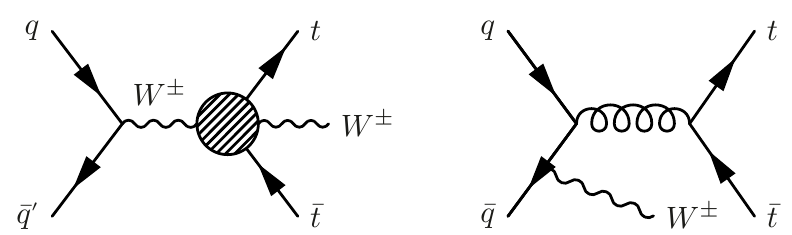
Figure 18. Left : schematic Feynman diagram for the EW-induced t (cid:22) tW process and its embedding of the t W t W subamplitude. Right : sample Feynman diagram for the QCD-induced t (cid:22) tW , which ! does not probe modi(cid:12)ed top-EW